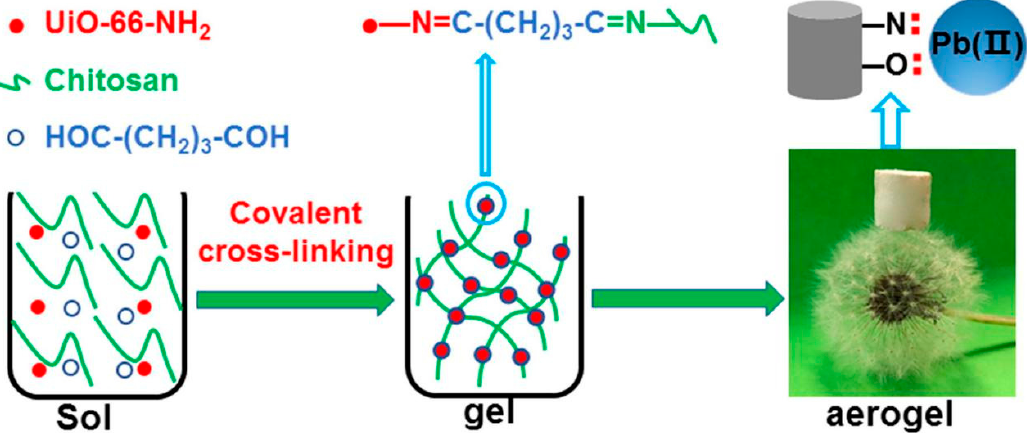
Figure 6. Synthesis of UiO-66–NH 2 –CS aerogel monolith (UNCAM). Reproduced with permission from [85]. Copyright Academic Press Inc., 2020.